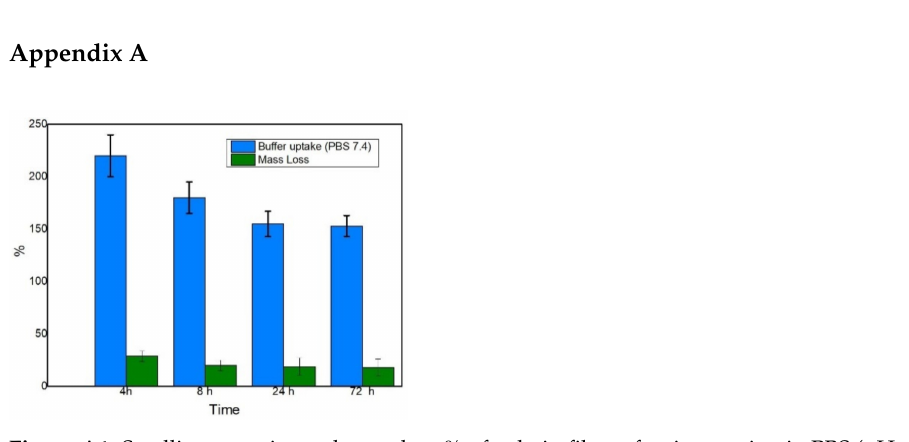
Figure A1. Swelling capacity and mass loss % of gelatin films after immersion in PBS (pH =